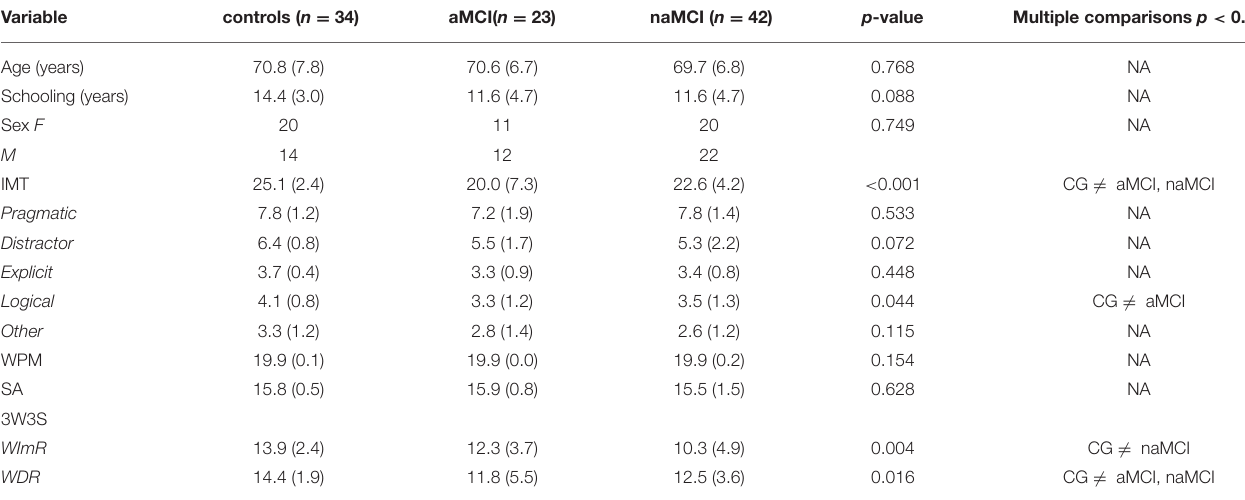
TABLE 2 | Demographic variables and performance on tests according to diagnostic